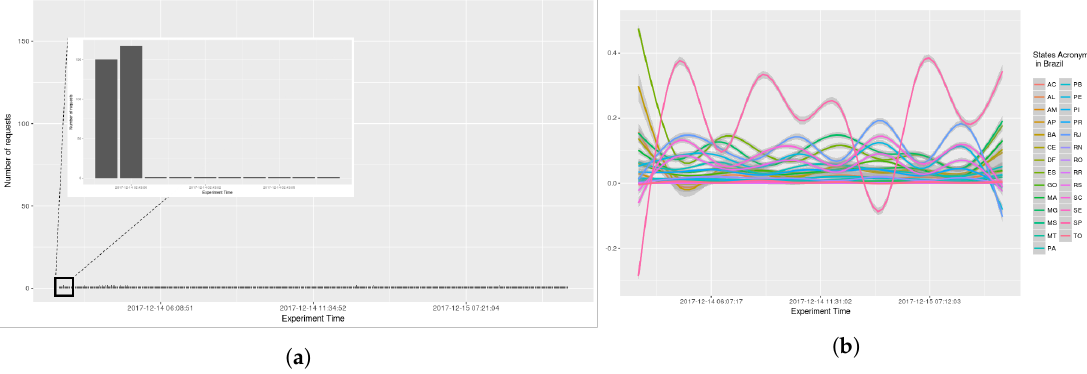
Figure 16. Scenario 03—Time Frequency. ( a ) Stations in the whole country of Brazil; ( b ) Stations grouped by